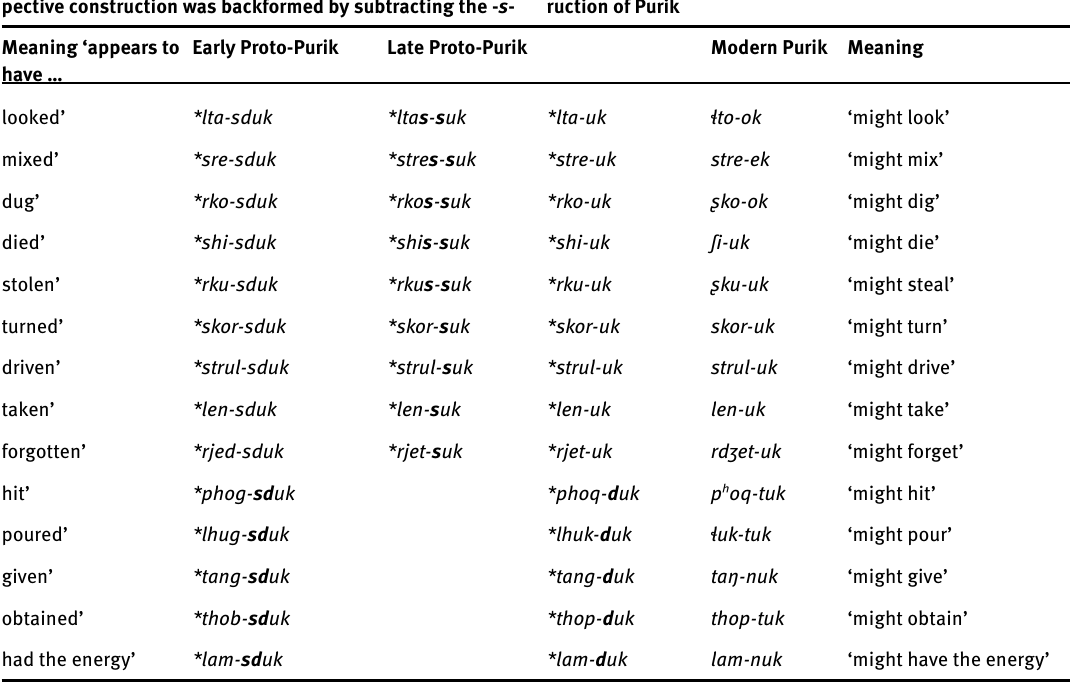
Table 2: Reconstructed and attested forms of V- s(d)uk and backformed V -(t/n)uk Reconstructed resultative construction from which the pros- Reconstructed and attested forms of the prospective pective construction was backformed by subtracting the - s -